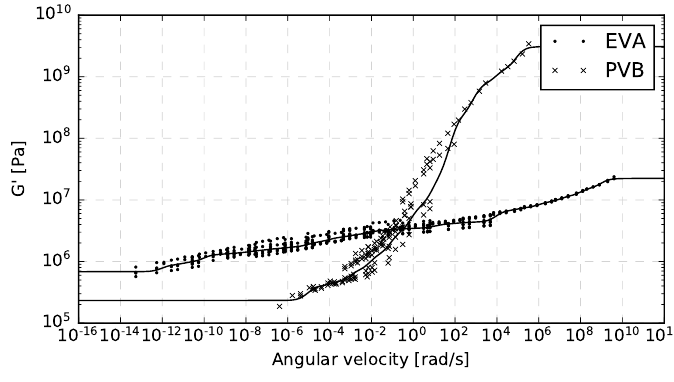
Figure 15. Master curves fitted to all experimental data at 20 ◦ C for the EVA and PVB